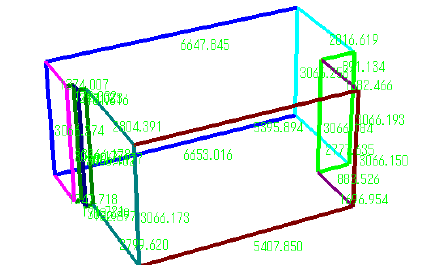
Figure 9. 3D room shape model of room with real scale size.